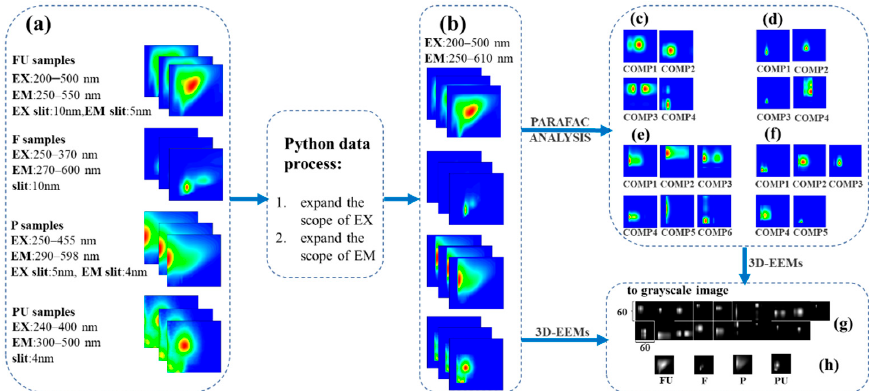
Figure 2. ( a ) Corrected data by Raman normalization; ( b ) Adjust the excitation ranges to: 200–550 nm, emission: 250–610 nm; ( c ) FU components (PARAFAC results); ( d ) F components; ( e ) P component; ( f ) PU components; ( g ) Grayscale image of 3D-EEMs components; and ( h ) Original 3D-EEMs grayscale image. This figure shows the data processing method in this paper, in which the grayscale images are generated by the samples EEMs and components EEMs, rather than the contour image, and pixels represent fluorescence intensity. In ( b ), the reason why the range is set as this range is to preserve the characteristic information of all 3D-EEMs. By using the bilinear interpolation method to interpolate 3D-EEMs, the size of the gray image is 60 ×